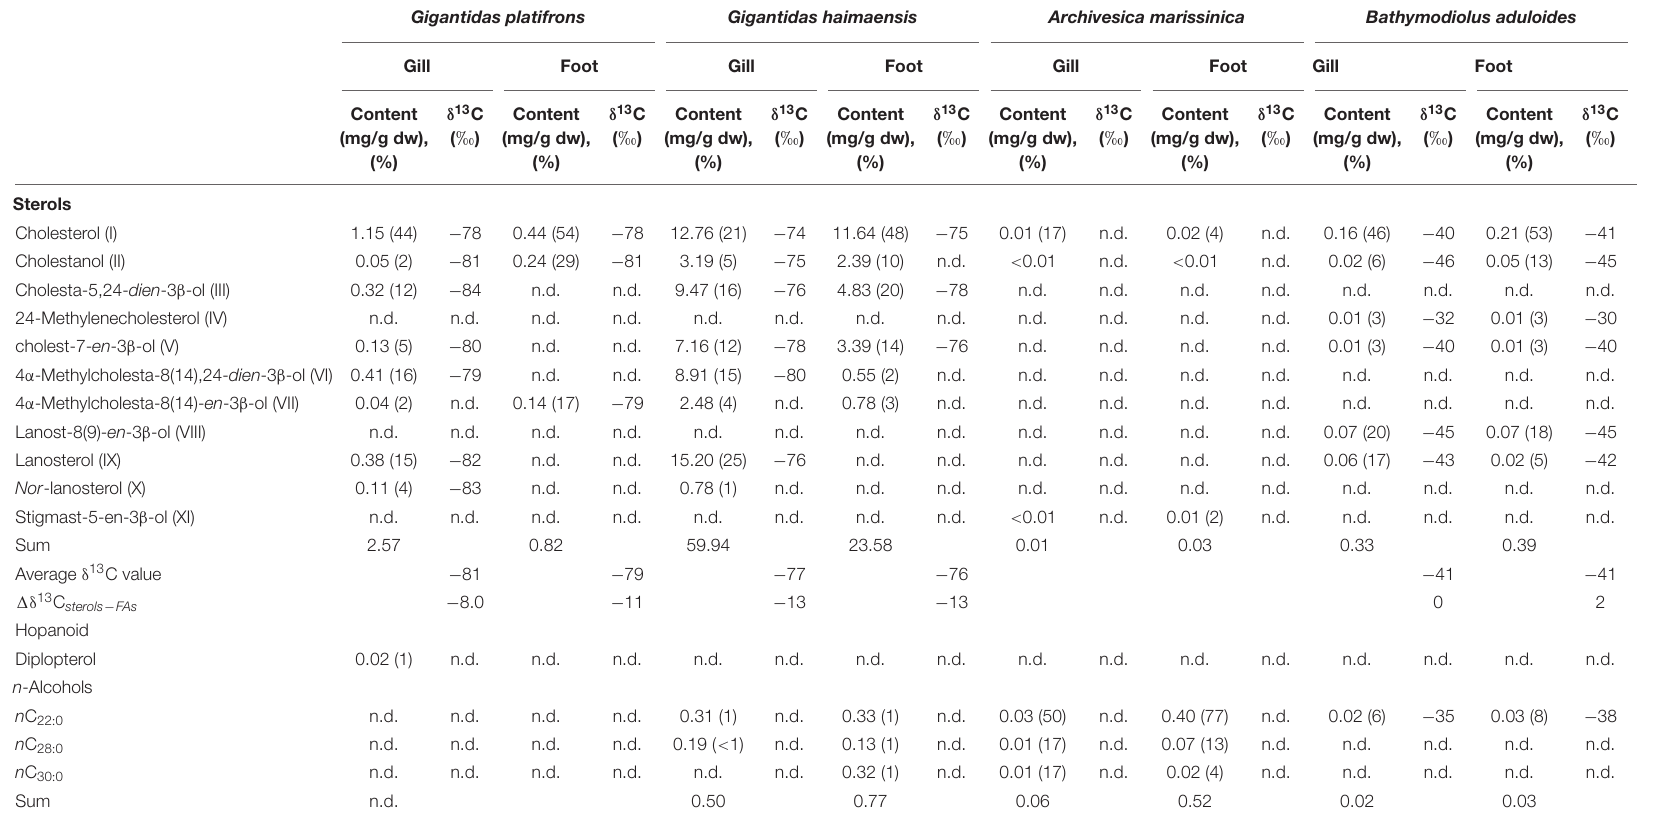
TABLE 3 | Contents and isotopic compositions of sterols, hopanoid, and n -alcohols from bivalve